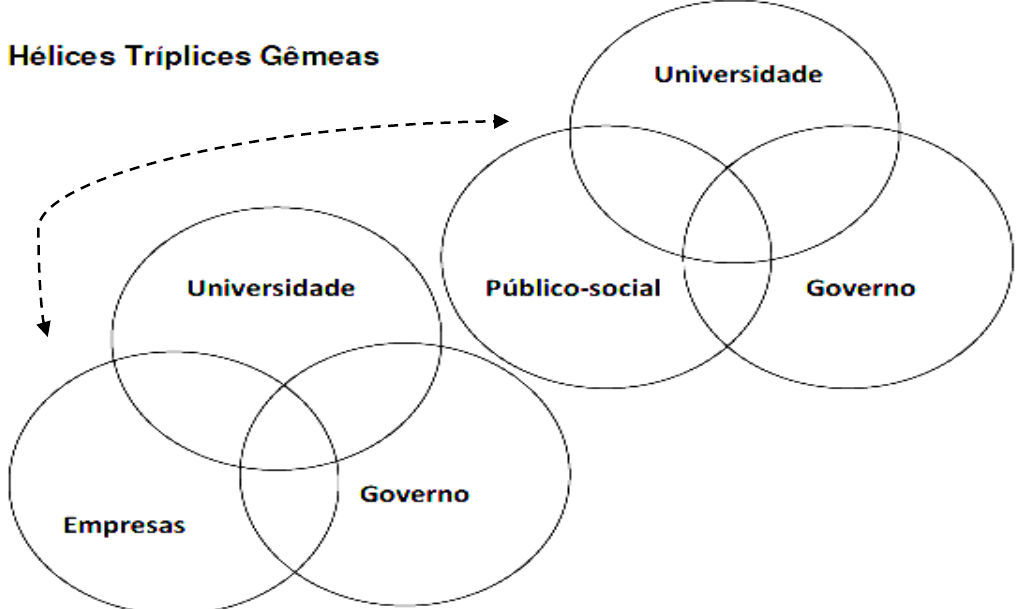
Figura 4. Modelo de hélices tríplices gêmeas. Fonte: